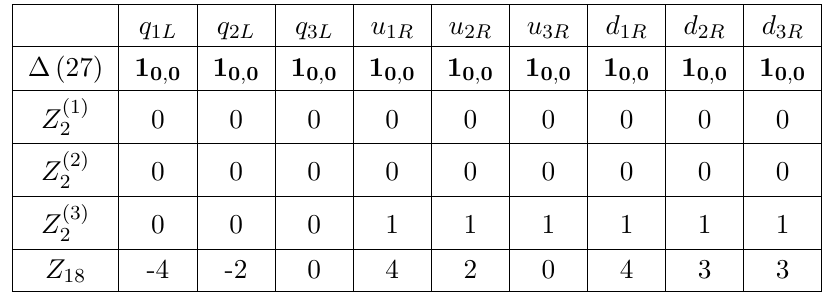
Table 2 . Quark assignments under the ∆ (27) × Z (1) between the multiple Z 2 symmetries.